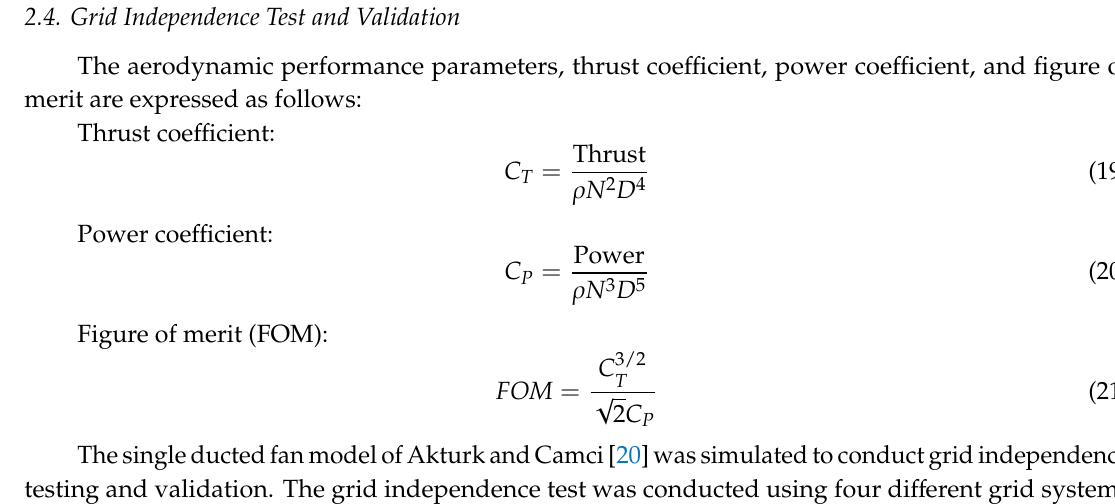
Figure 2. The grid system, boundary, and interface conditions of the counter-rotating ducted fan.